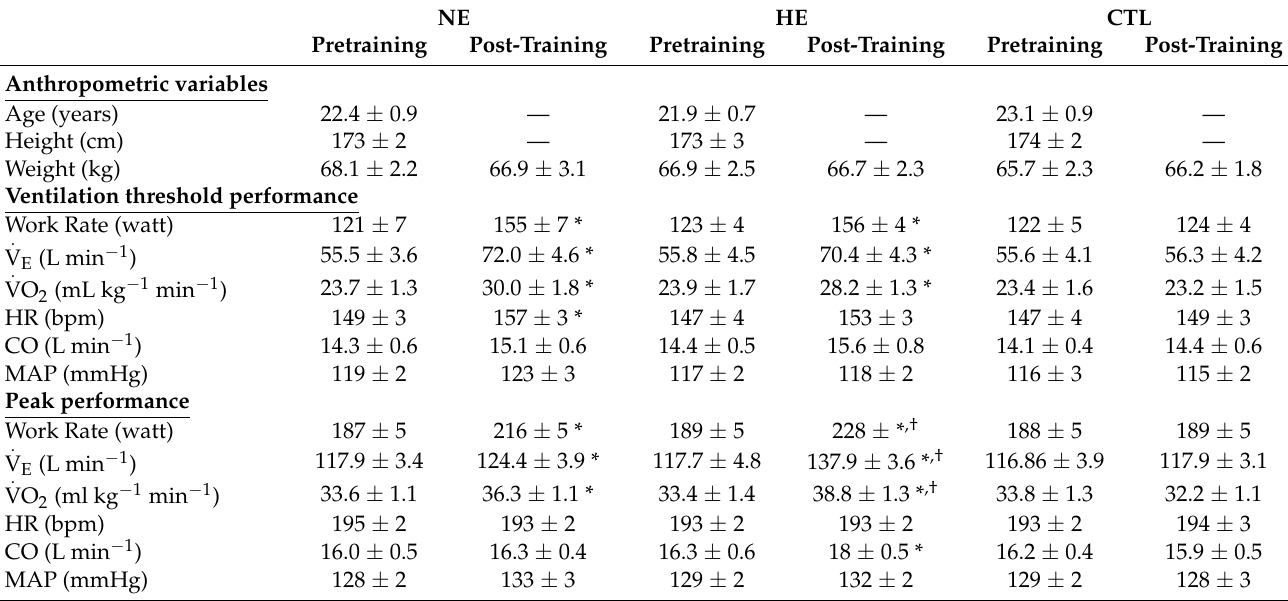
Table 1. Anthropometric data and cardiopulmonary exercise test (normoxia) performance in NE and HE.